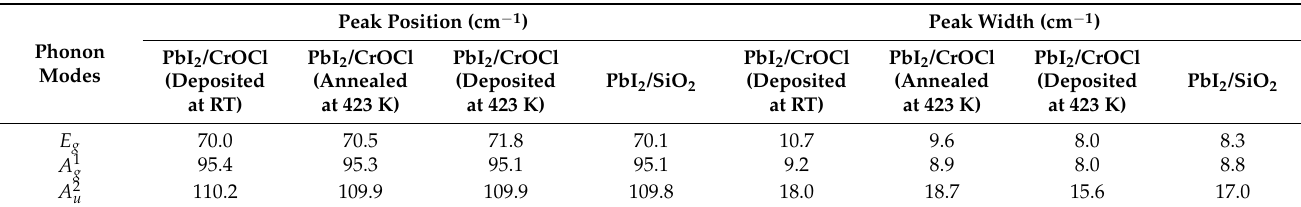
Table 1. Phonon mode information of PbI 2 /CrOCl heterostructure and PbI 2